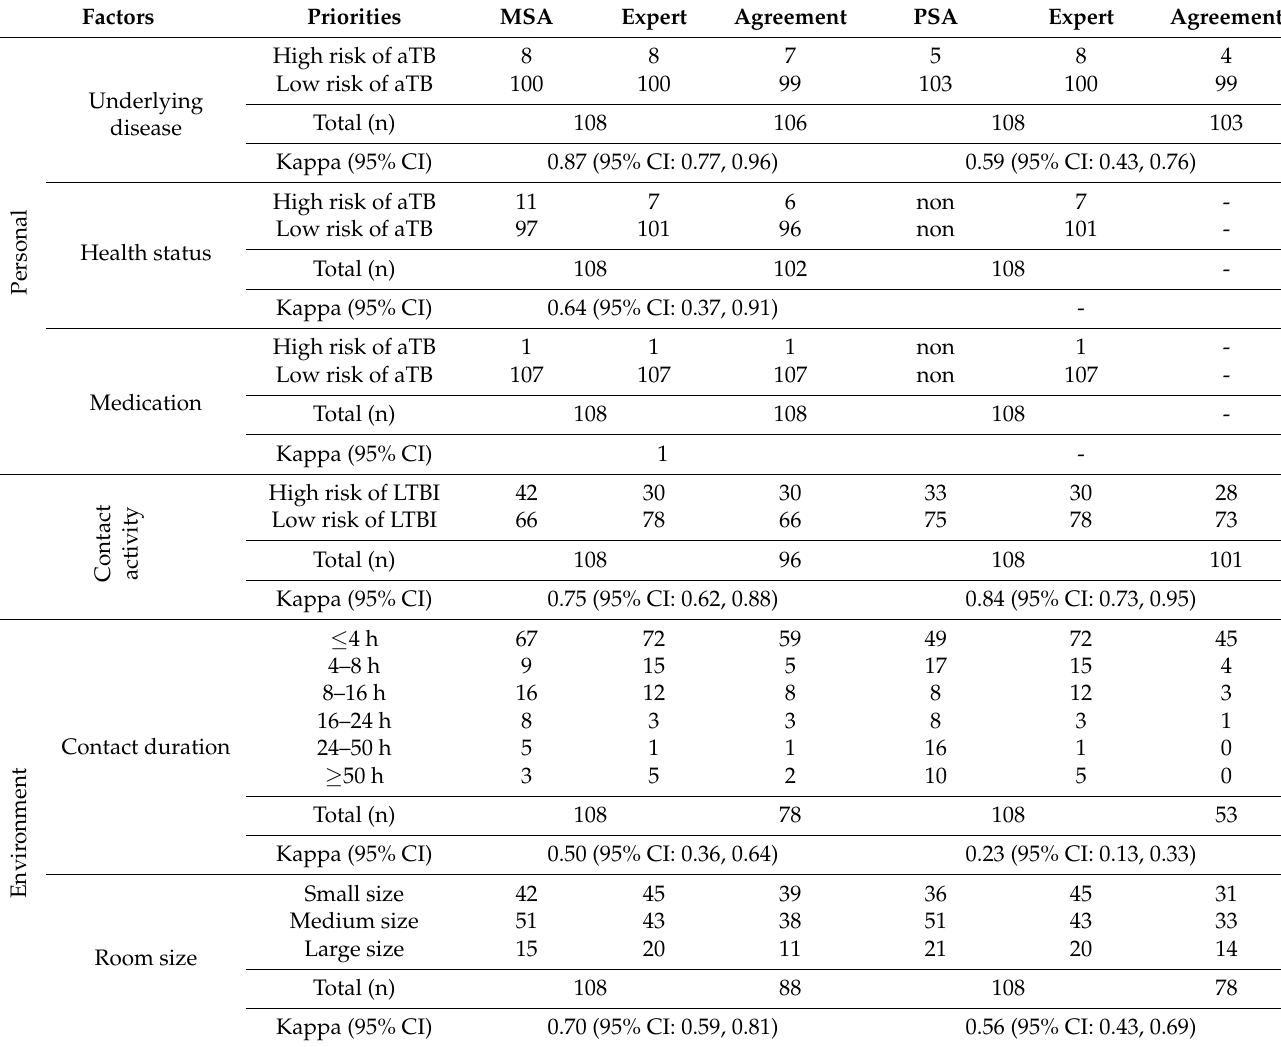
Table 4. Kappa agreement of factors between MSA and the experts vs. PSA and the